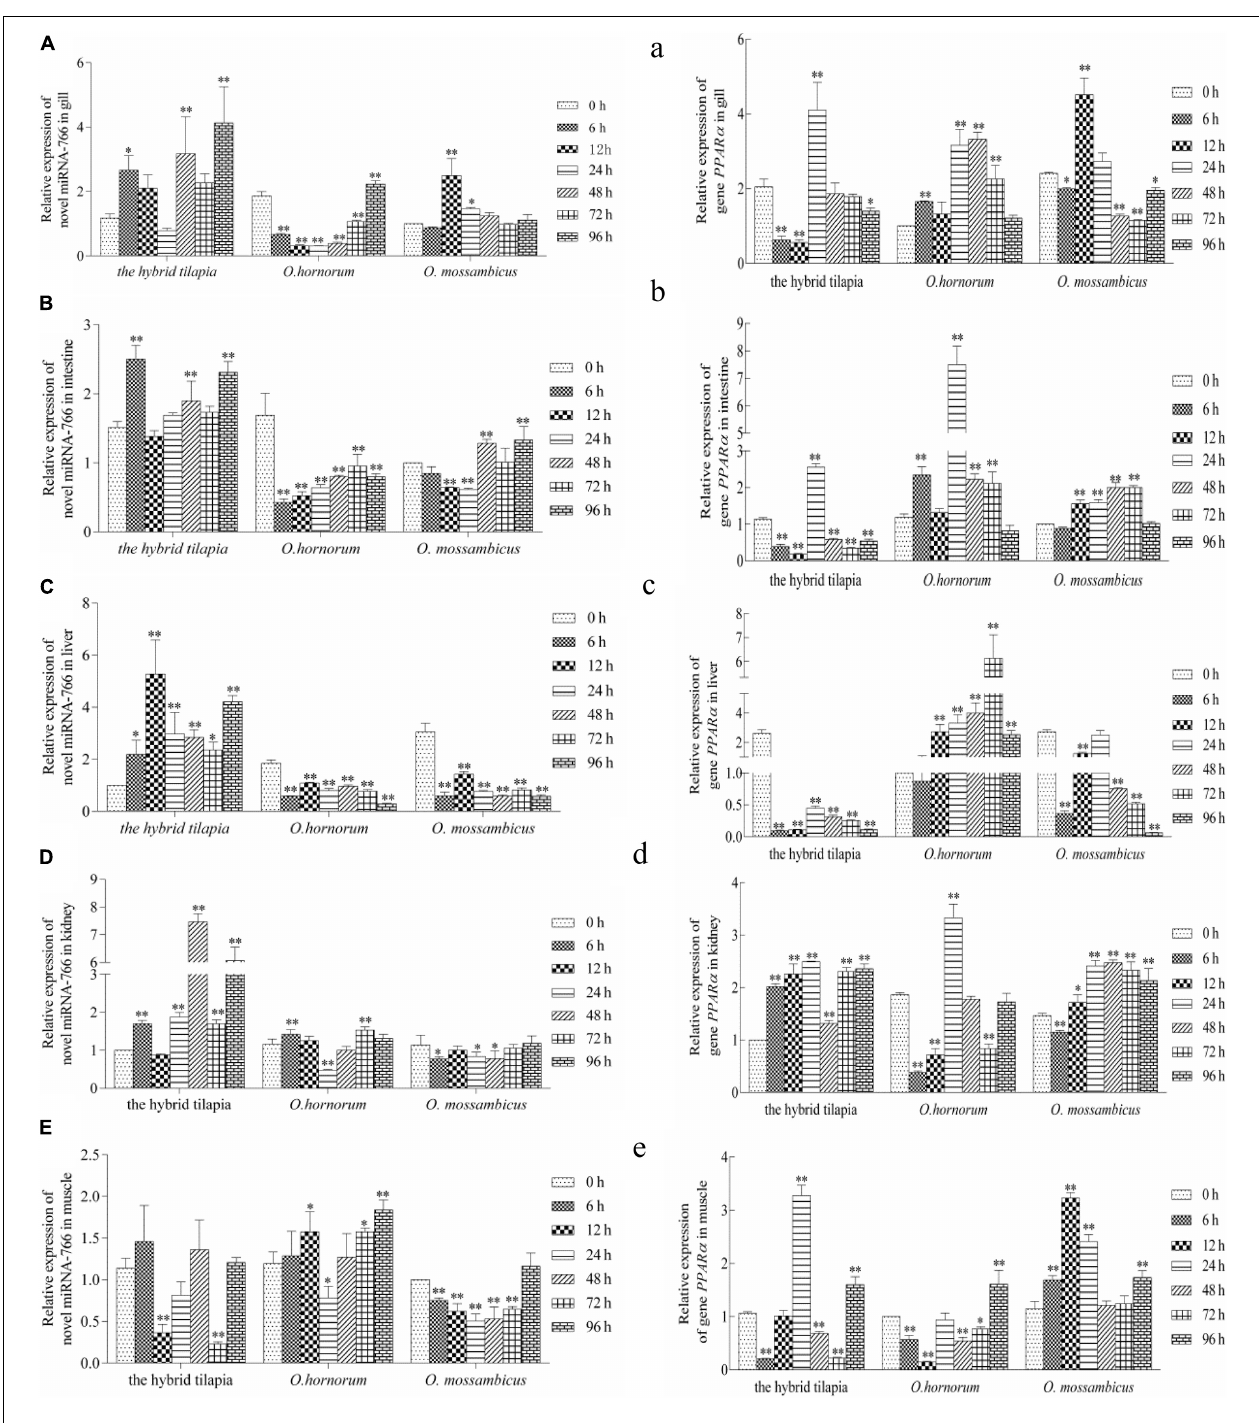
FIGURE 5 | Expression levels of selected novel miRNA-766 (A–E) and its target gene PPAR α (a–e) in the control group (C group) and alkalinity stressed group (A group) in the hybrid tilapia and its parent samples for 96h. “ ∗ ” and “ ∗∗ ” indicate significant differences ( P < 0.05 and P < 0.01, respectively) between values obtained pre-(0 h) and post-alkali stress (6, 12, 24, 48, 72, and 96 h), by paired-samples t -test.